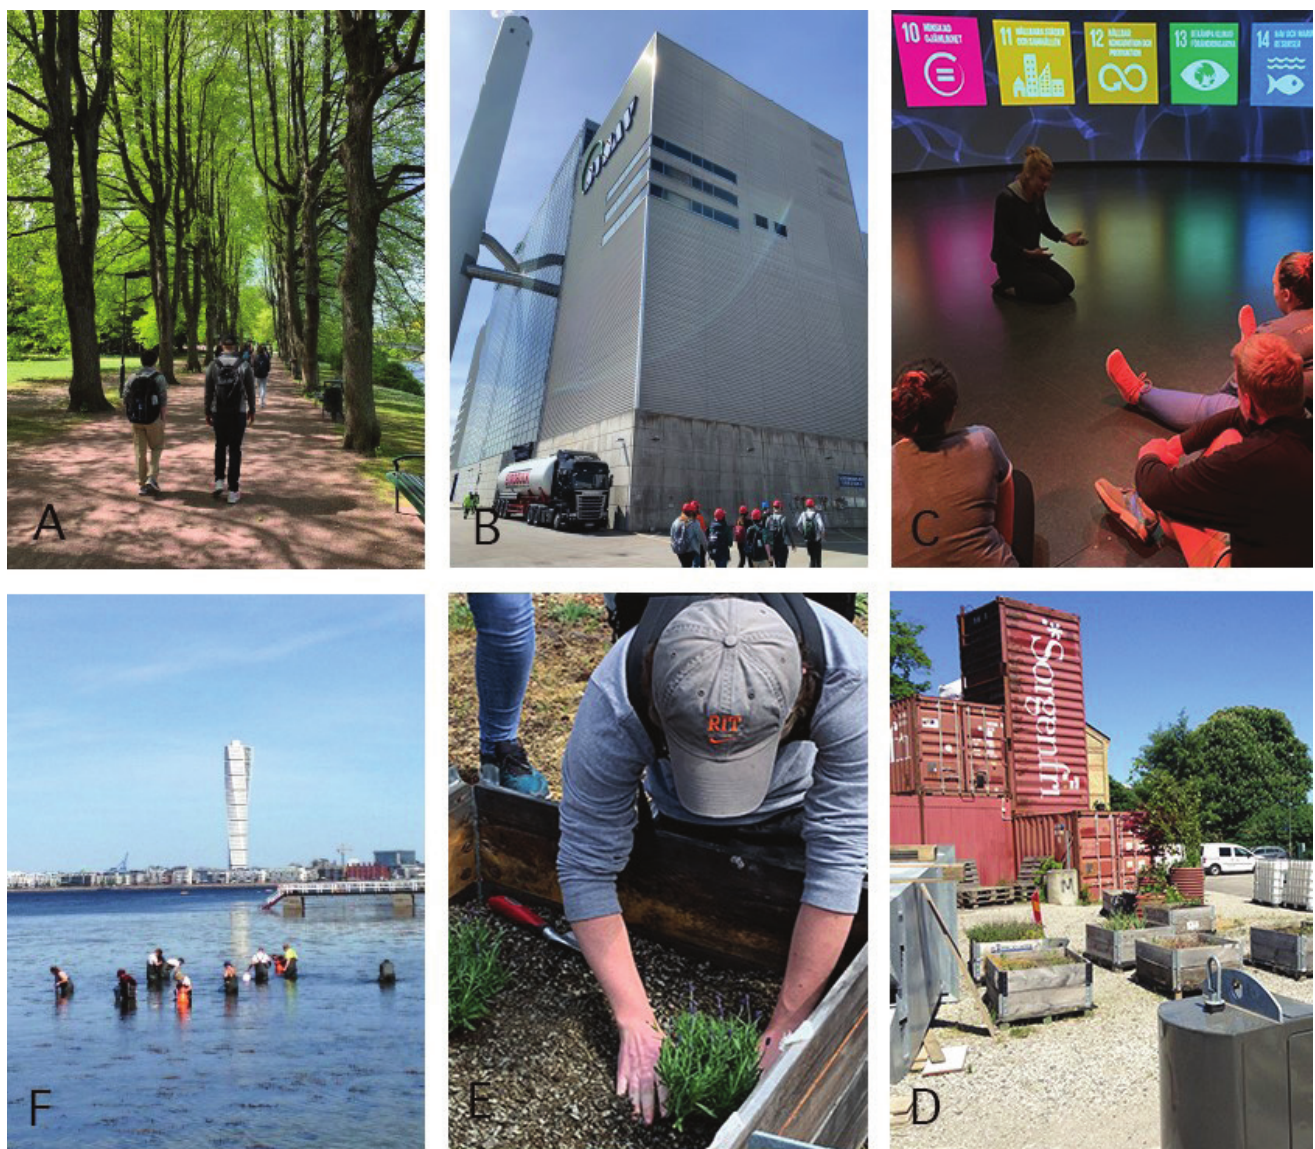
Figure 1: Clockwise from top left: A) Exploring the green spaces of Malmö in Kungsparken; B) Educational Tour of SYSAV, a waste- to-energy plant; C) Tour of Kretseum, a museum dedicated to educating secondary students about wastewater and recycling (note the UN SDGs in the background) ; D) Sorgenfri ecodistrict, with a waste management and composting demonstration center; E) Students planting in a green roof at the Scandinavian Green Roof Institute; F) Collecting samples of sea life in the Öresund at Sea U, a marine educational